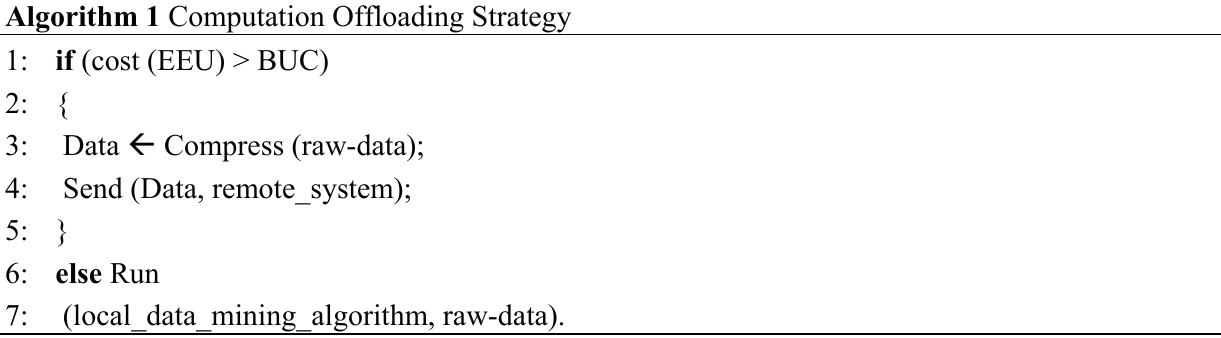
Algorithm 1 Computation Offloading